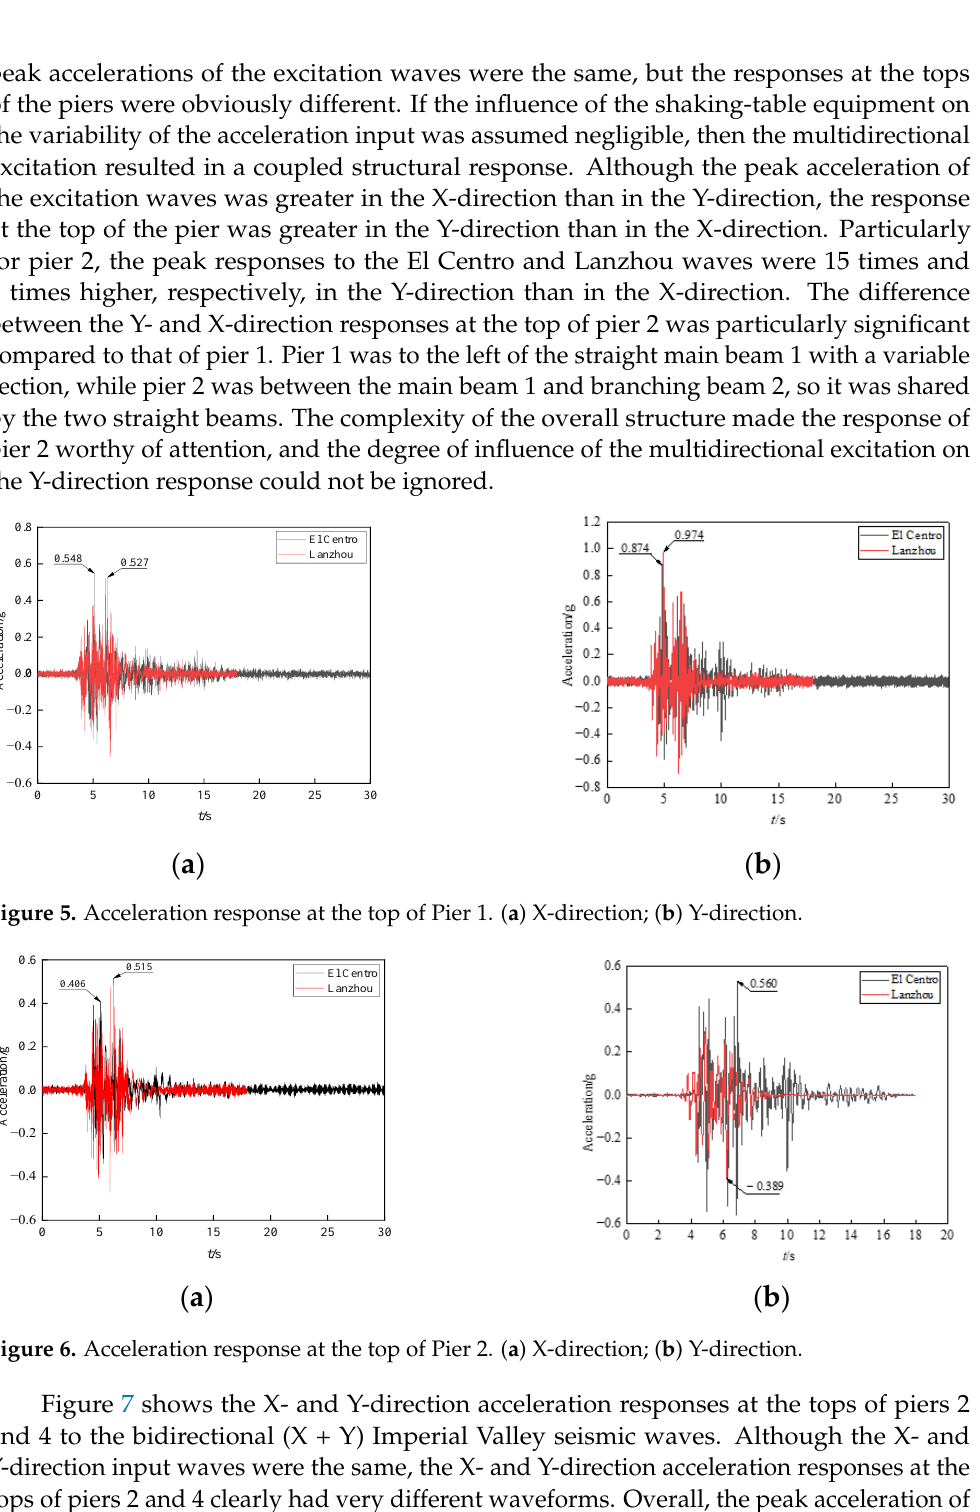
( b ) Figure 7. Acceleration response at the top of the piers. ( a ) X-direction ( b ) Y-direction. Table 5 presents the X- and Y-direction acceleration responses at the tops of the piers subjected to bidirectional (X + Y) and tridirectional (X + Y + Z) El Centro and Imperial Valley waves. The responses, at the tops of piers 1-3, were greater with the multidirec- tional El Centro wave than with the bidirectional wave. In contrast, the responses of the pier tops were less with the multidirectional Imperial Valley wave than with the bidirec- tional wave. This indicated that the multidirectional excitation did not necessarily increase the structural response of the structure. Under multidirectional excitation, the responses at the tops of piers 4 – 6 exceeded those of the other three piers, which supported straight beams. The response was the greatest at the top of pier 6. The above analysis showed that the response of the pier tops to multidirectional ex- citation was always greater in the Y-direction than in the X-direction. Thus, additional attention should be given to the structural performance of piers in the cross-bridge direc- tion (i.e., tangential to the main beam) in designing irregular bridges.